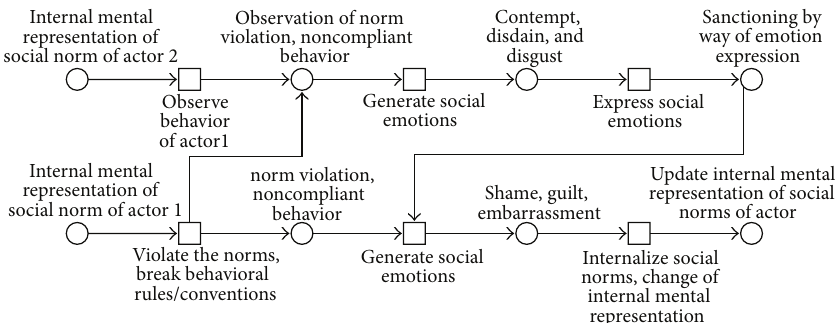
Figure 6: Internalization, adapted from Fix et al.